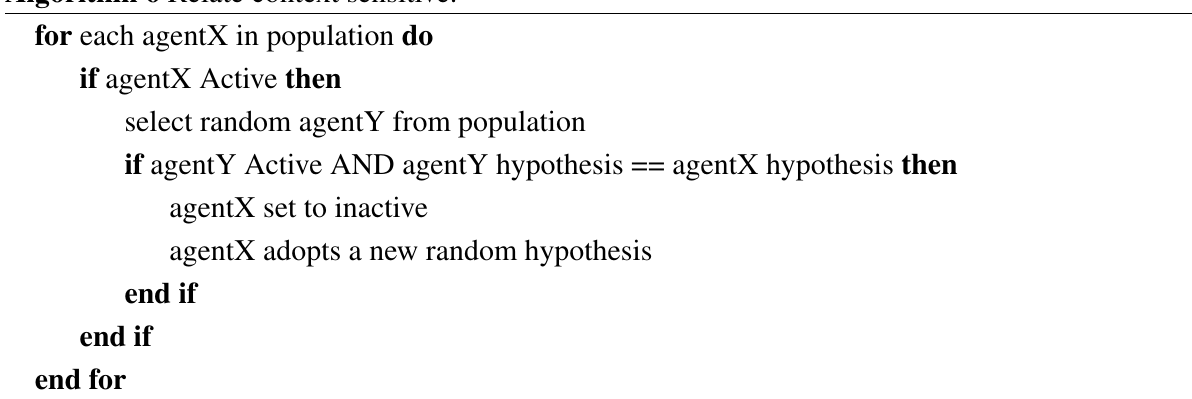
Algorithm 6 Relate context